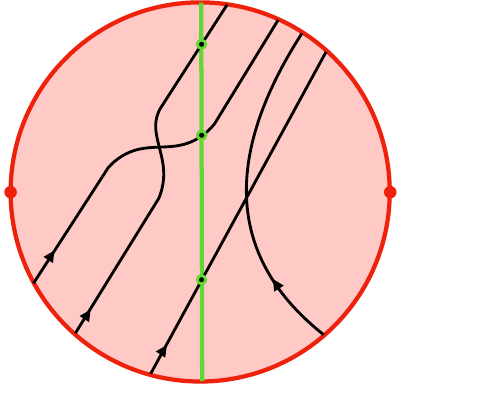
Figure 7 . The delete-a-matter-matter-chord rule (3.4). These pink disks are the middle region in figure